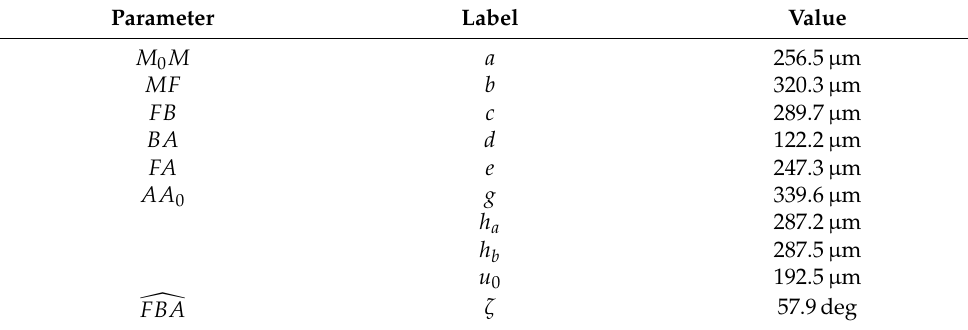
Table 1. Geometric parameters of the